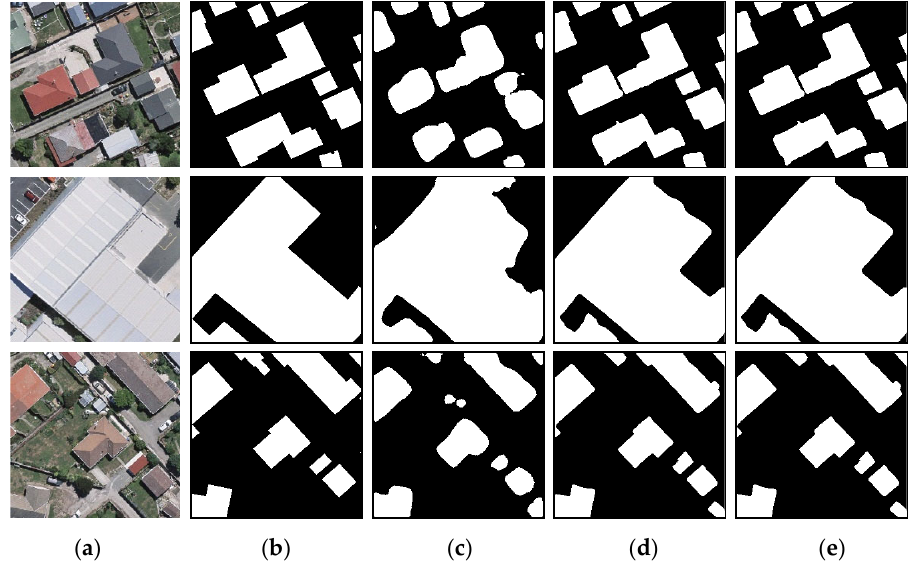
Figure 16. Comparison of ablation visualization results on the Wuhan University building change detection dataset, ( a ) 2016 image, ( b ) 2016 ground truth, ( c ) baseline, ( d ) baseline + CycleGAN, ( e ) baseline + CycleGAN + the post ‐ processing update strategy.